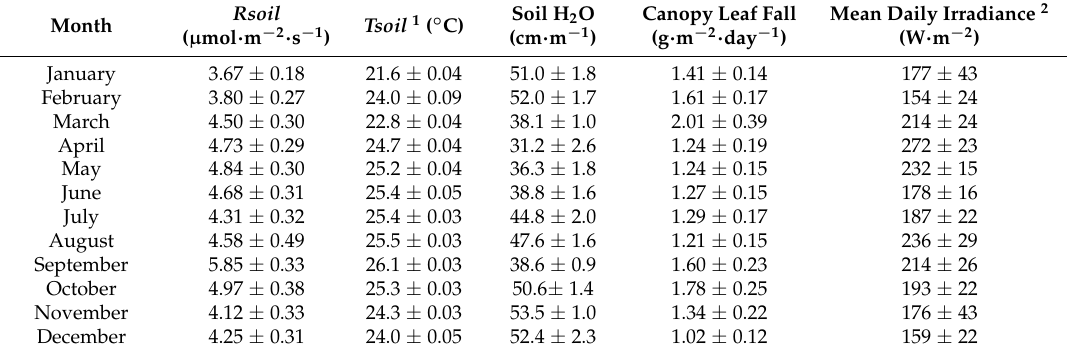
Table 3. Mean monthly soil respiration ( Rsoil ), soil temperatures ( Tsoil ), soil water contents, canopy leaf fall and incident solar radiation across 24 monodominant plantations of six tree species in the Atlantic lowlands of Costa Rica. Not all species were measured over the duration of the study; the mean values for each month were determined from the mean monthly values determined for each species. Soil temperatures refer to 2008–2010, when they were measured at 10 cm depth. Error intervals are ± 1